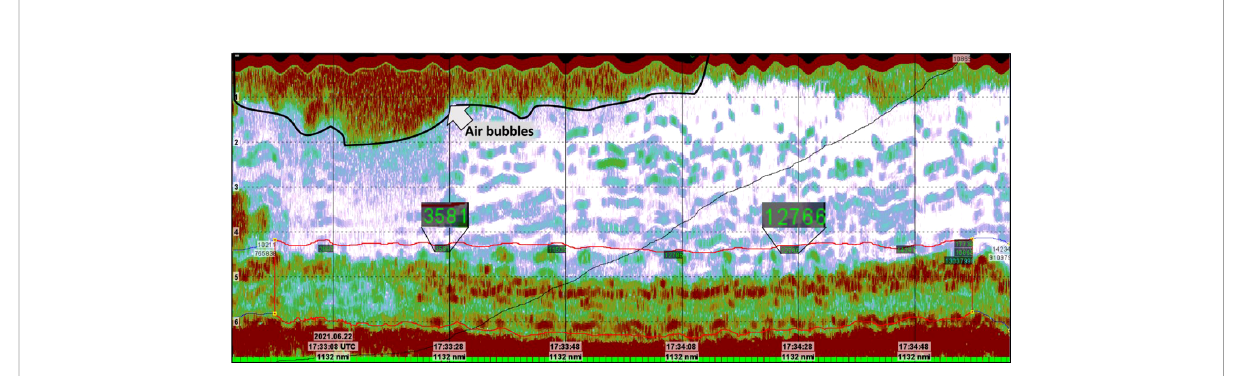
FIGURE 10 Echogram from Helgeland station 174. Notice the vast difference in estimated NASC-value due to the presence of air bubbles in the upper water